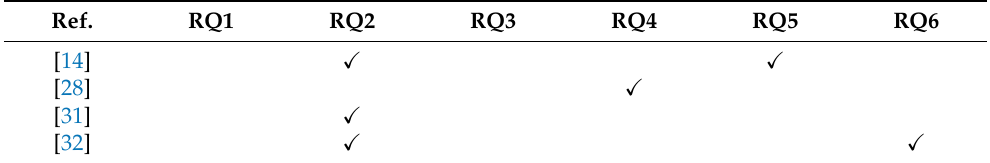
Table 4. RQs tackled in previous related